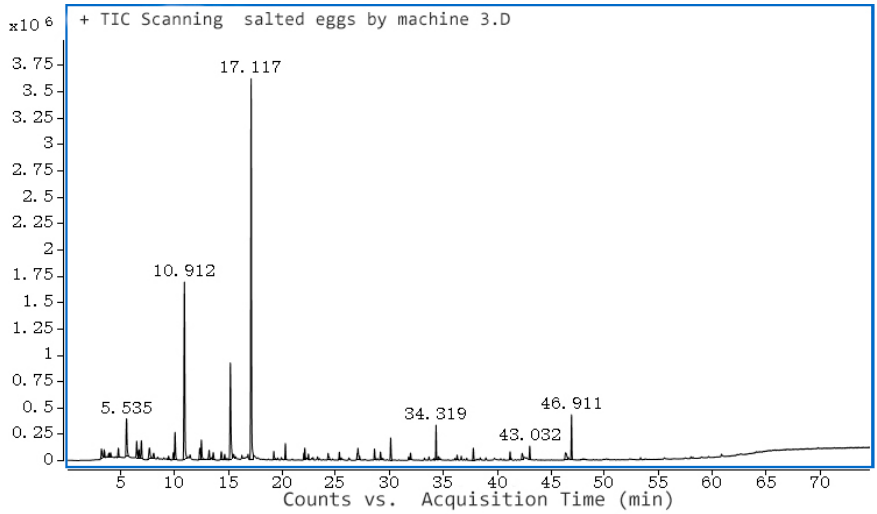
Figure 7. GC-MS of volatile compounds of quickly pickled egg yolk.